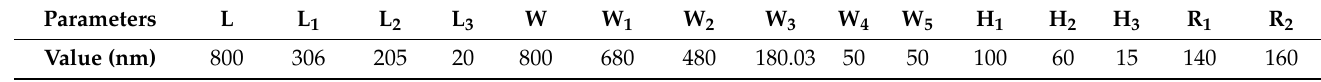
Table 1. MMA unit cell’s structural